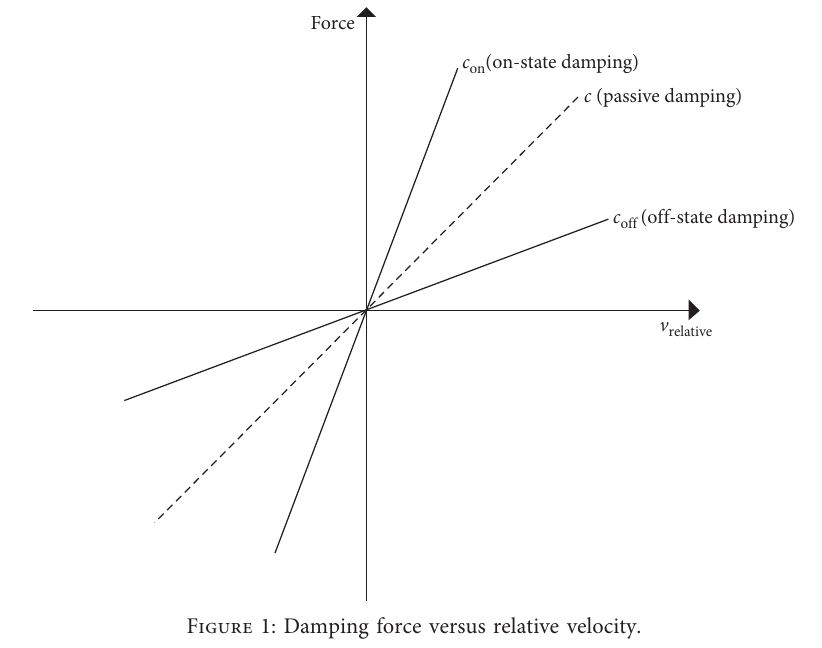
Figure 1: Damping force versus relative velocity.